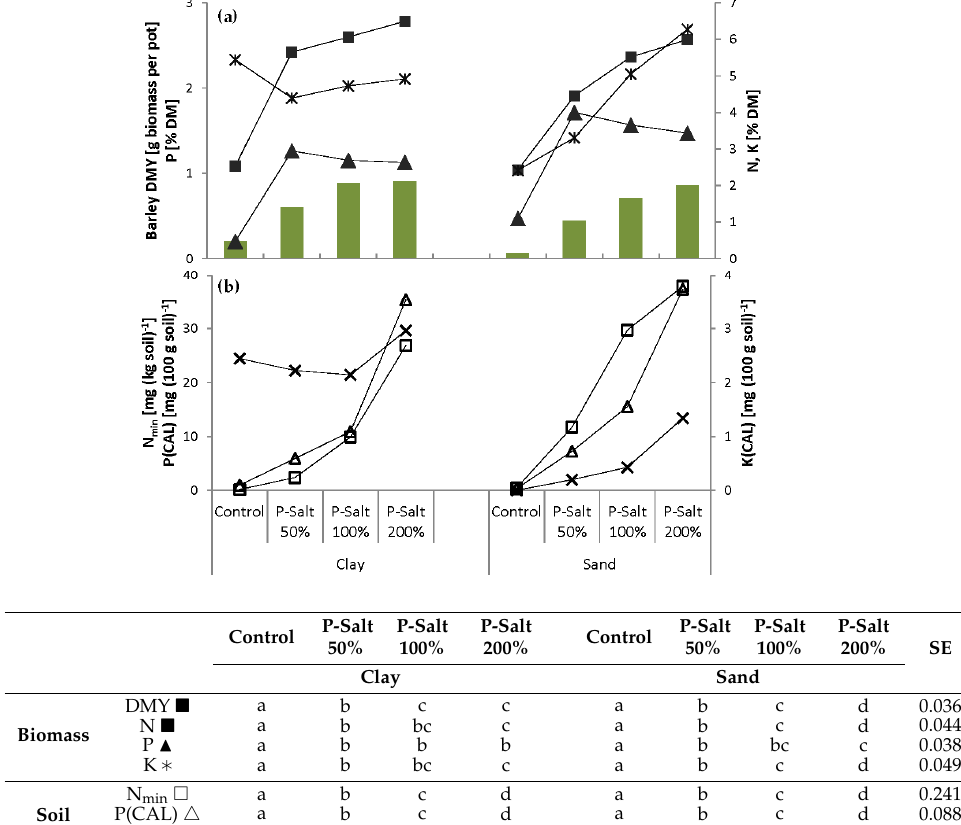
Figure 1. Dry matter yield (DMY) and nutrient concentration in biomass, graph upper panel, ( a ), and soil, graph lower panel, ( b ), of barley treated with increasing P ‐ Salt levels compared to untreated control. Different letters in the table indicate statistically significant differences between treatments ( α = 0.05, n = 4). SE: pooled standard error of the mean.